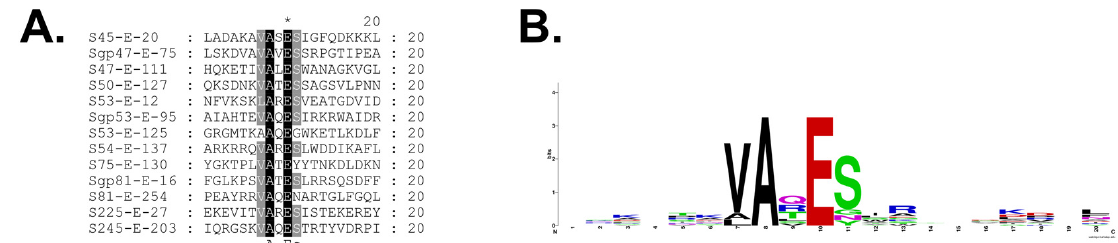
Figure 5. Cleavage specificity of the SPN3US prohead protease (gp245). ( A ) Alignment of the regions incorporating 10 residues upstream to 10 residues downstream of the cleavage site in SPN3US head proteins that are cleaved by gp245. Gp245 cleaves C- terminal to a glutamate residue (indicated with an asterick). ( B ) Sequence logo of the SPN3US cleavage sites generated by WebLogo (https://weblogo.berkeley.edu/logo.cgi, accessed on 4 January 2023).